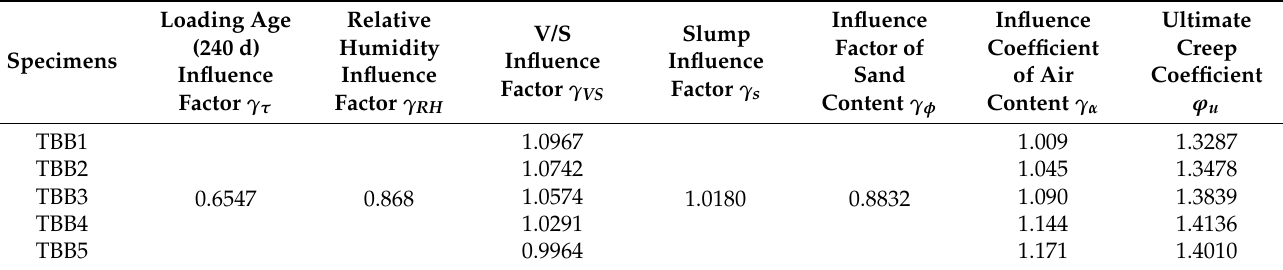
Table 10. Value of influence coefficient of creep